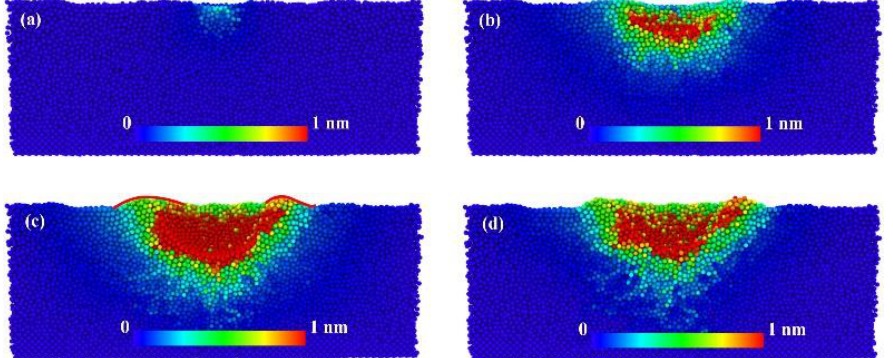
Figure 10. The atomic displacement of the Cu-Ta alloy film during nanoindentation process are the cross-section snapshots of XY plane at the indentation depths of ( a ) 0.2, ( b ) 1.2, ( c ) 2.8 and ( d ) 2 nm, respectively.